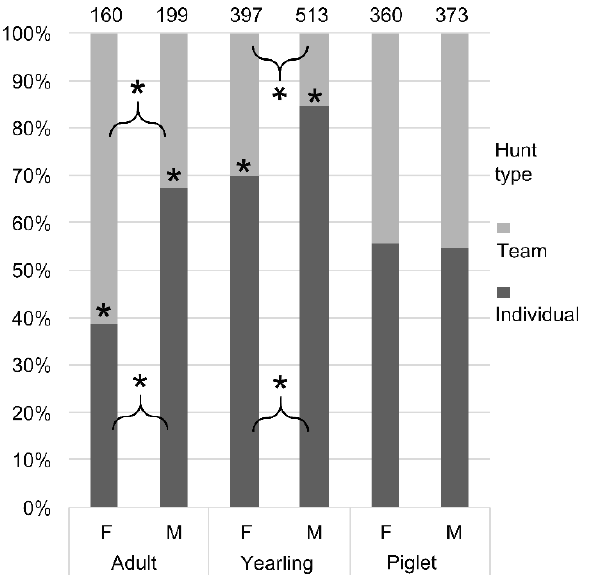
Figure 1. Number of culled wild boar ( Sus scrofa ) in the period 1965–2016 in the Czempi ń hunting area in western Poland. The groups (Females [F] vs Males [M] and Individual vs Team hunt type) are compared by post-hoc according to the fitted Poisson model with interaction sex × age × method. * indicate differences at p < 0.05.